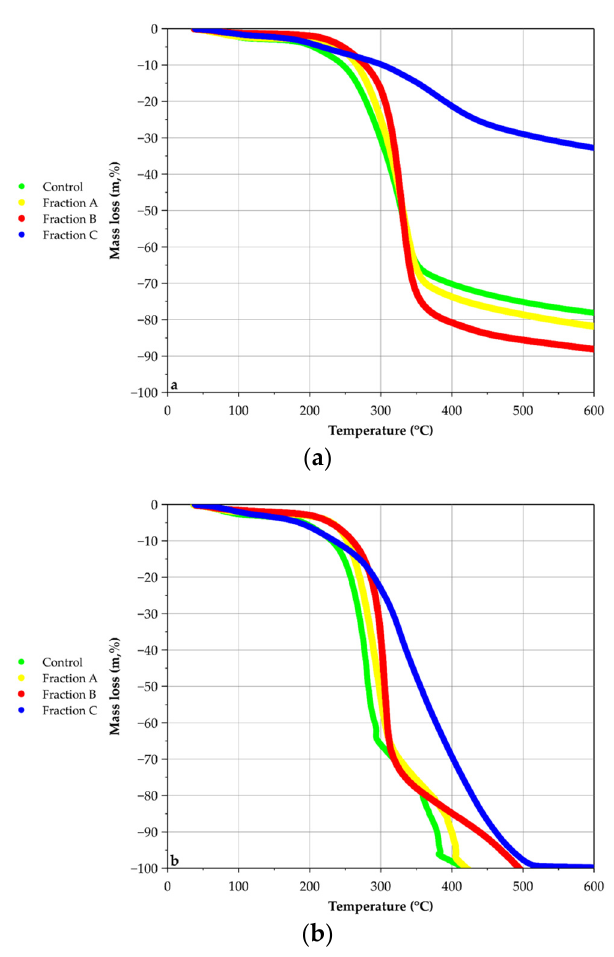
Figure 4. TGA hemp shiv fraction curves under Ar ( a ) and O 2 ( b ).